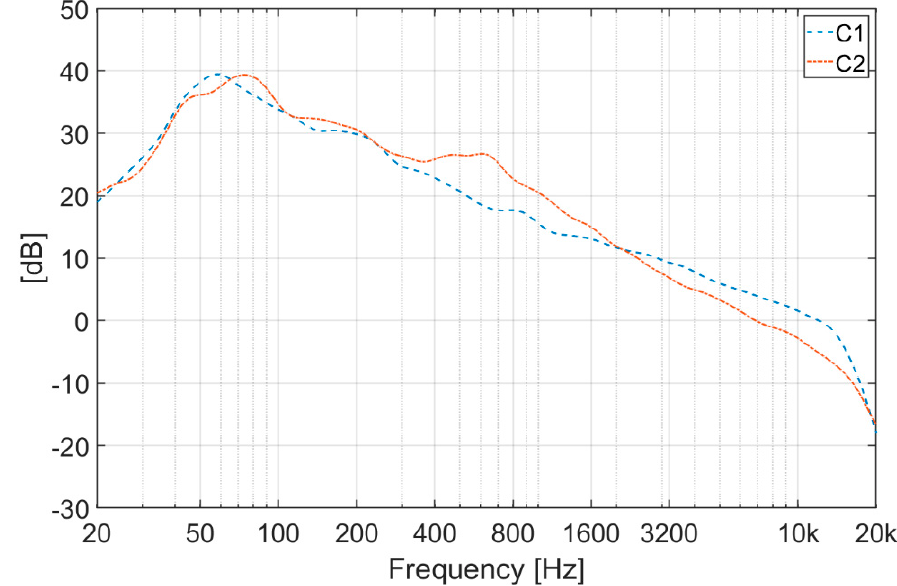
Figure 10. One-third octave spectral averages of the programs in C1 and C2.